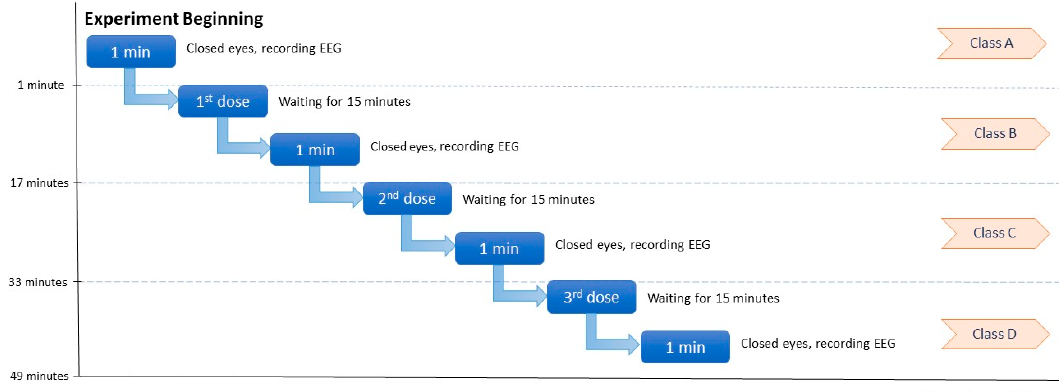
Figure 4. The timeline of the experiment. Each dose is a 50 mL whisky (40% alc/vol). The total time in the end of each stage is shown in the orange box.